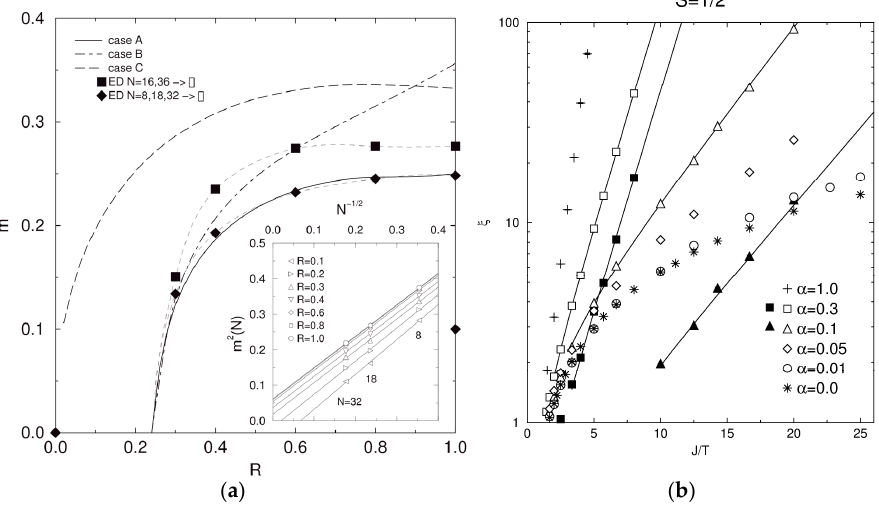
Figure 4. ( a ) Ground-state staggered magnetization m of the rectangular lattice for different R values calculated by various approaches; the short-dashed lines are fits to the exact diagonalization (ED) data. Cases A , B , C correspond to different choice of parameters in Green’s function approach. The inset demonstrates the deviation of the ED results from the N-1/2 scaling law at R < 0.3 (solid lines are least-squares fits). (Reproduced with permission from reference [72]); ( b ) The correlation length for the S = 1/2 HAF on the rectangular lattice as a function of the inverse temperature for various R values ( α stands for R ). Open (filled) symbols denote the correlation length along (perpendicular to) the chain. For small α ( α < 0.05), the values of inter-chain correlation length are smaller than one lattice constant and are not shown in the figure. Solid lines are fits to Equation (5), showing the exponential dependence of ξ on 1/ T . (Reproduced with permission from reference [75]).